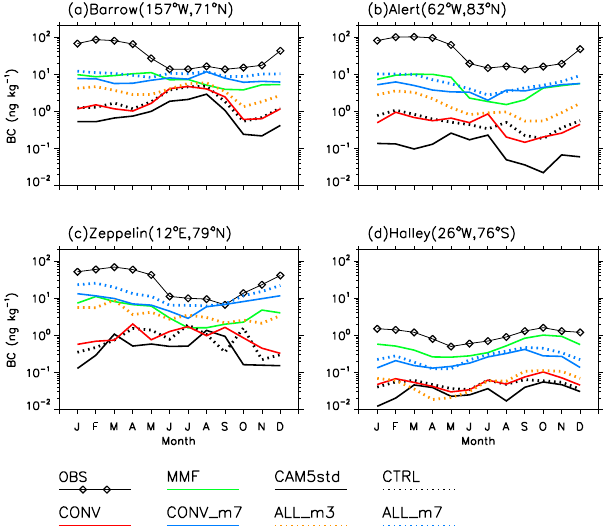
Fig. 3. Observed and modeled monthly mean BC surface mixing ra- tios (ngkg − 1 ) at the four polar sites: (a) Barrow, (b) Alert, (c) Zep- pelin, and (d)